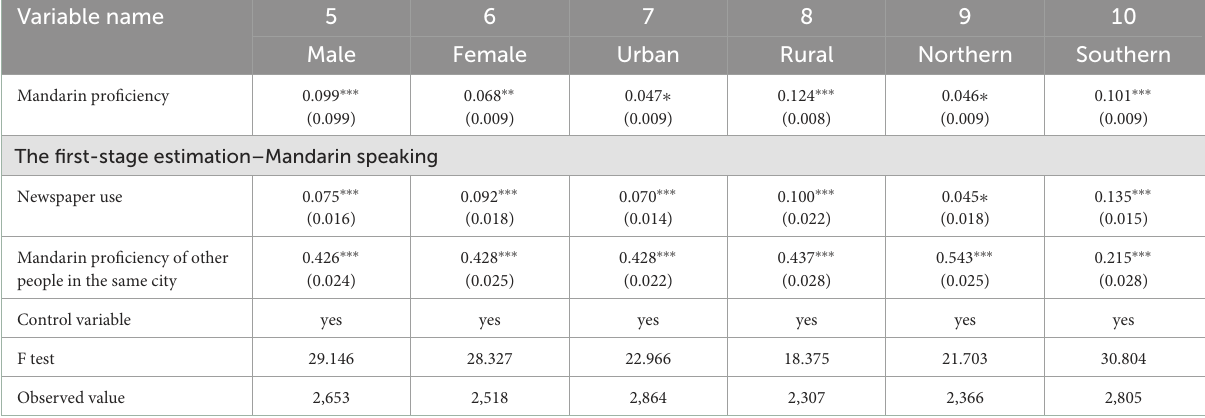
TABLE 4 Effects of Mandarin proficiency on donation behavior after grouping ( N =